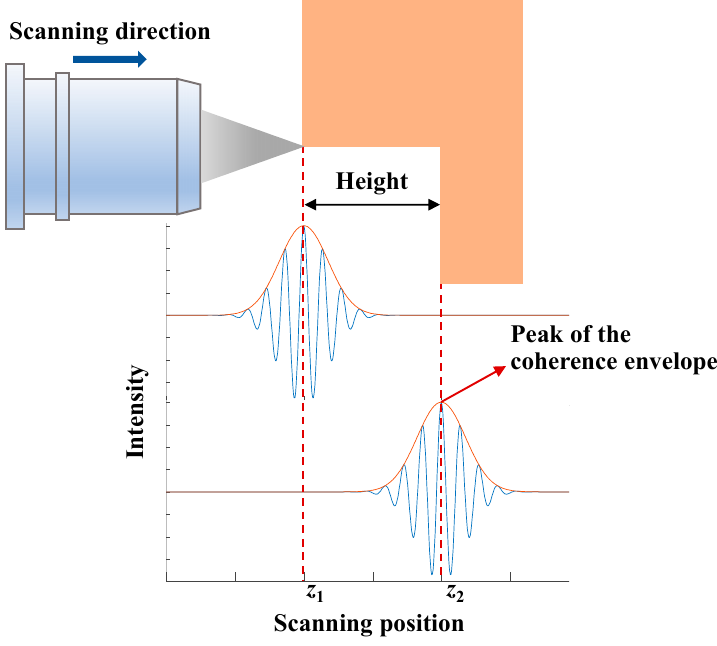
Figure 2. Illustration of data acquisition in VSI.